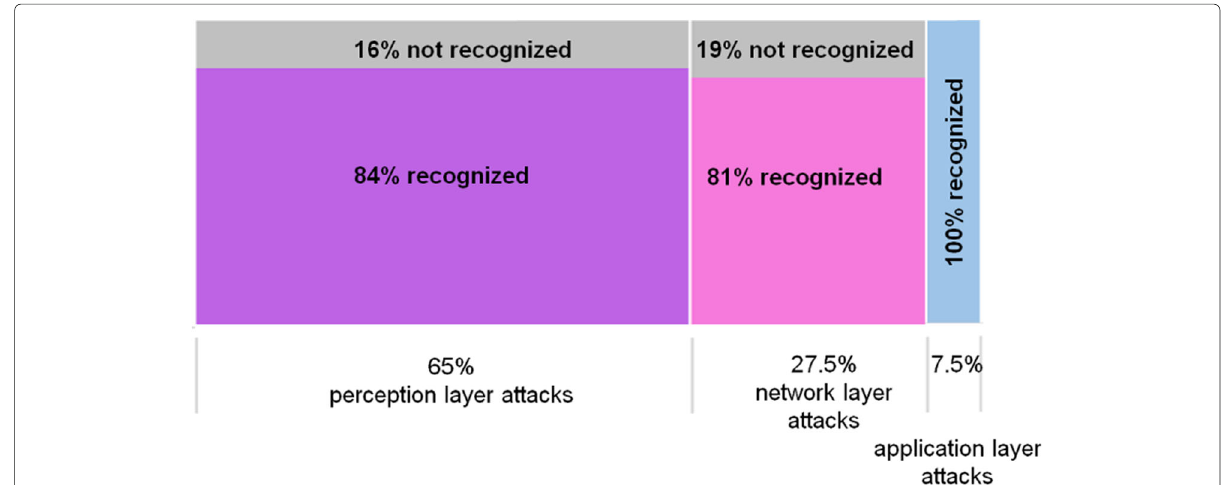
Fig. 9 Verification of the security